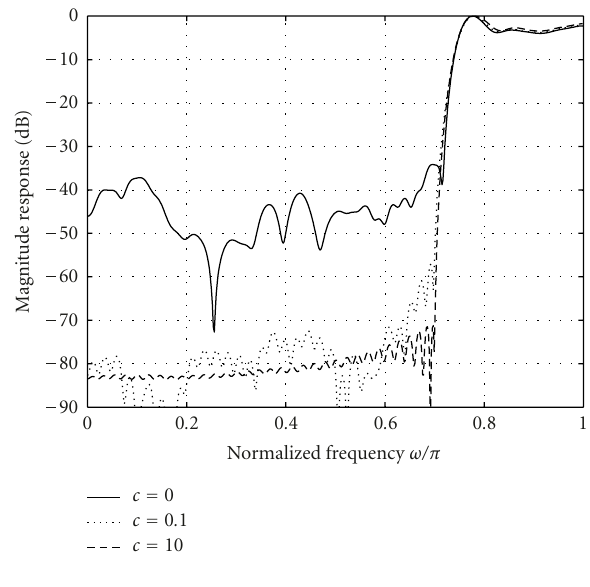
Figure 14: Magnitude response of H 1 ( z